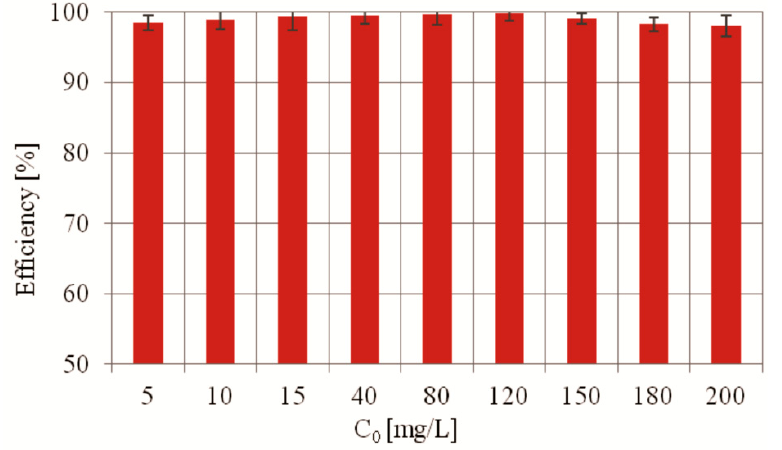
Figure 8. Efficiency of MO photocatalytic degradation as a function of the initial concentration of MO in the presence of PdCl2 biosilica photocatalyst. Experimental conditions: m (biosilica)—10 mg; T = 25 °C; t = 75 min; C 0 (MO)—5–200 mg/L; V (MO solution)—15 mL; pH—7.0.